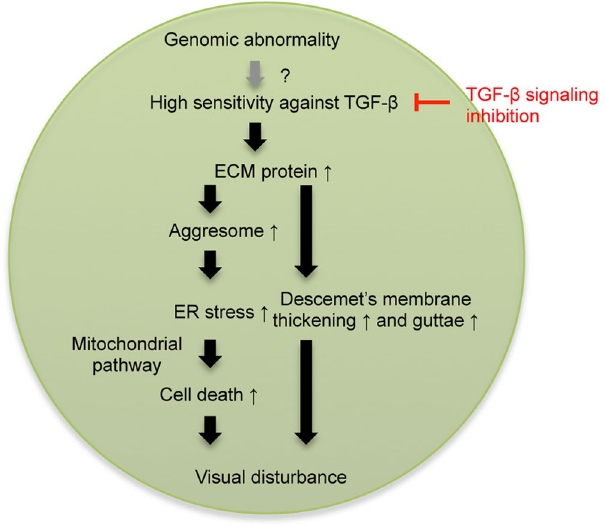
therapeutic target for treatment of